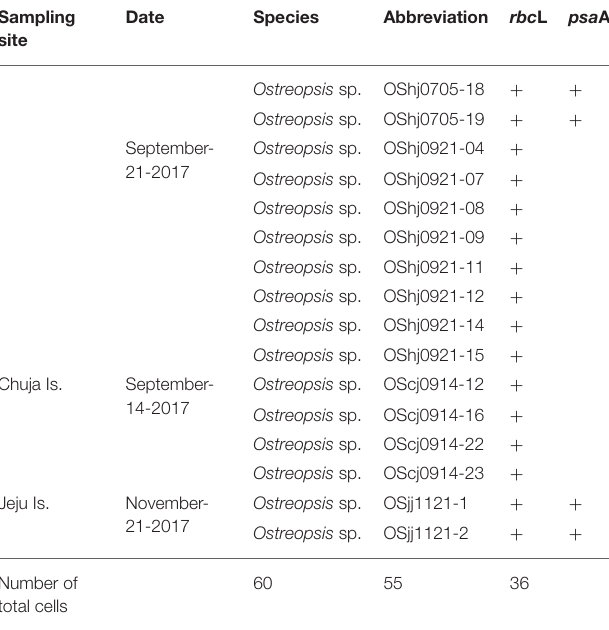
TABLE 1 | Summary of sampling sites, dates, and plastid genes sequenced for the ingested food particles within Ostreopsis cells isolated from field samples during this